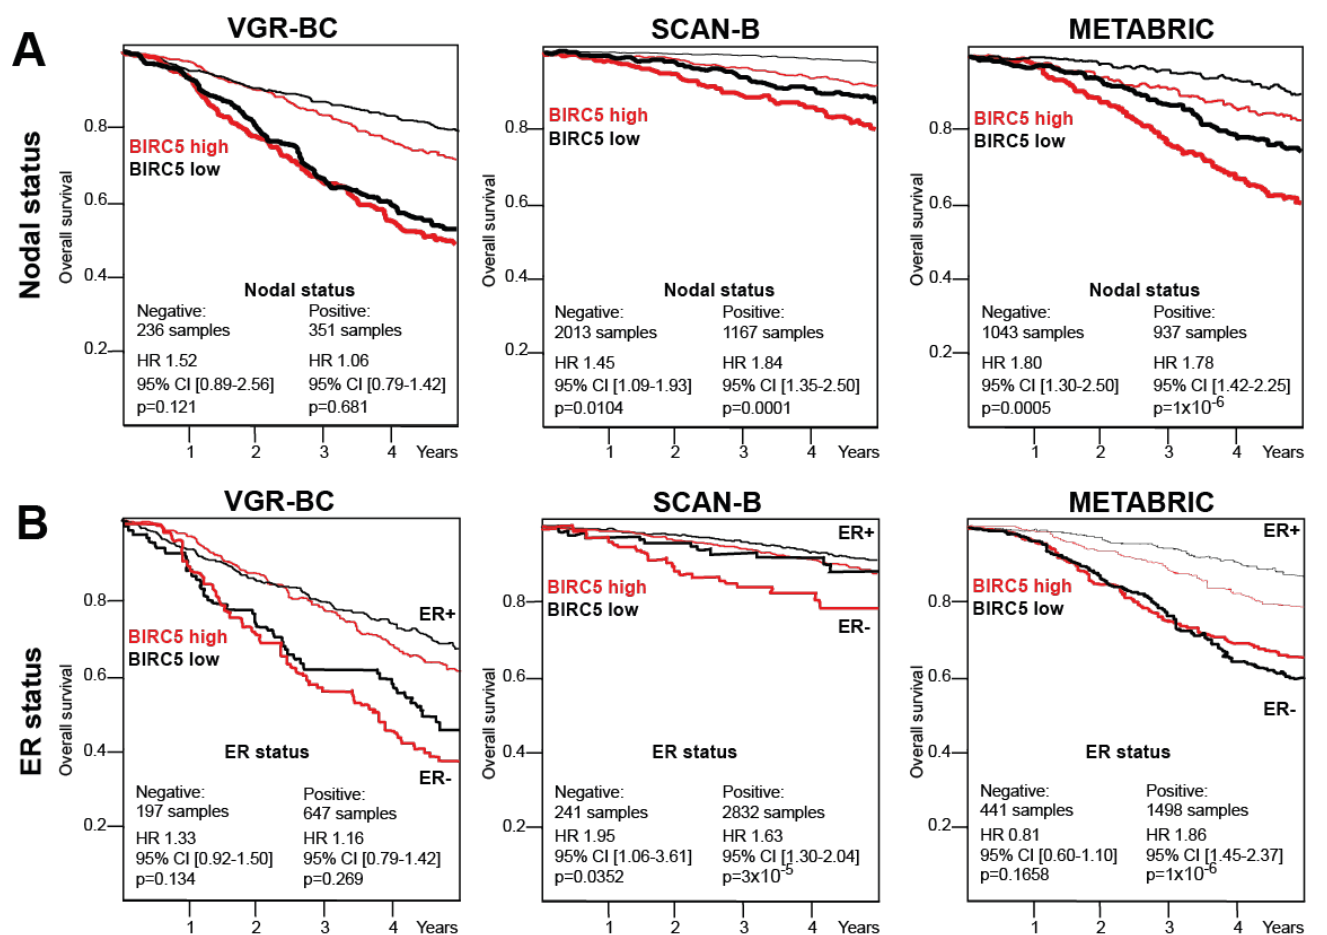
Figure 2. High levels of BIRC5/survivin are associated with poor survival prognosis independent of nodal and ER status. ( A ) Kaplan-Meier curves depict 5-year overall survival probability for patients of the VGR-BC, SCAN-B, and METABRIC cohorts. Data were split by BIRC5/survivin median levels of the protein in tumor lysates in VGR-BC and of the mRNA levels in SCAN-B and METABRIC. Graphs are shown for patients with (nodal positive, thick lines) and without (nodal negative, thin lines) BC metastases into lymph nodes. ( B ) Kaplan-Meier curves depict 5-year overall survival probability for the ER-positive (ER+) and ER-negative (ER − ) patients within the VGR-BC, SCAN-B, and METABRIC cohort. Data were split by BIRC5/survivin median levels of the protein in tumor lysates in VGR-BC and of the mRNA levels in SCAN-B and METABRIC. High BIRC5/survivin level survival curves are shown in red and low in black. Hazard ratio was estimated separately for high- and low-level patient groups.